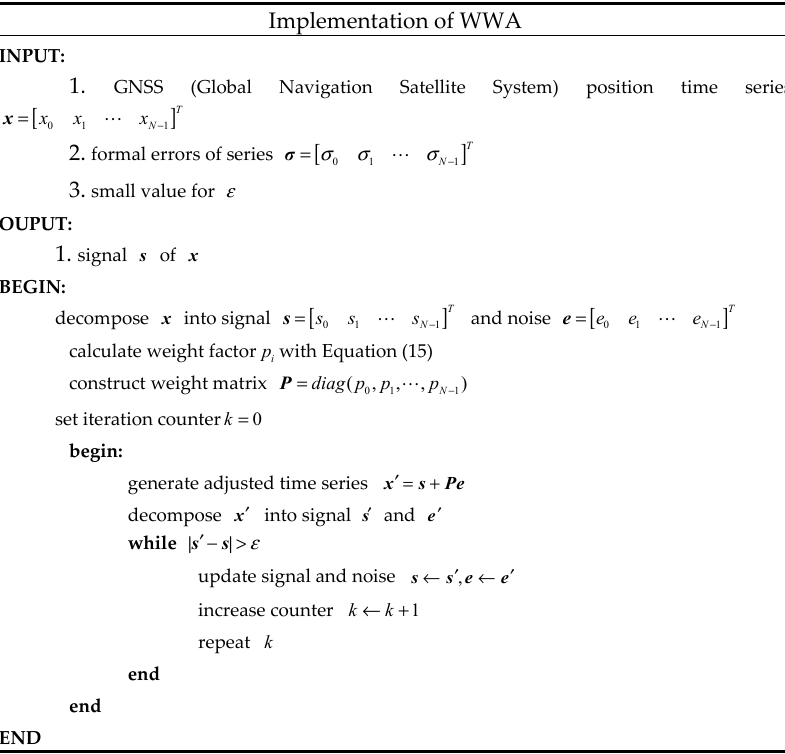
Figure 2. Symbolic algorithm of weighted wavelet analysis (WWA) for extracting signal from time series x with formal errors σ .